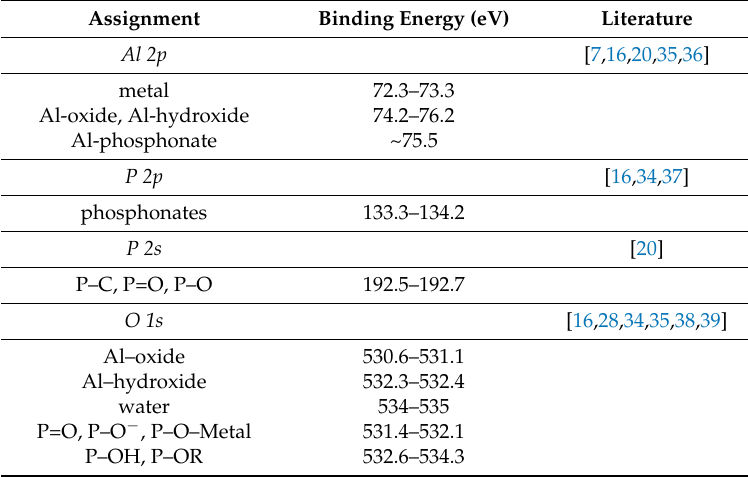
Table 2. XPS binding energies relevant to phosphonic acids modified aluminum surface.